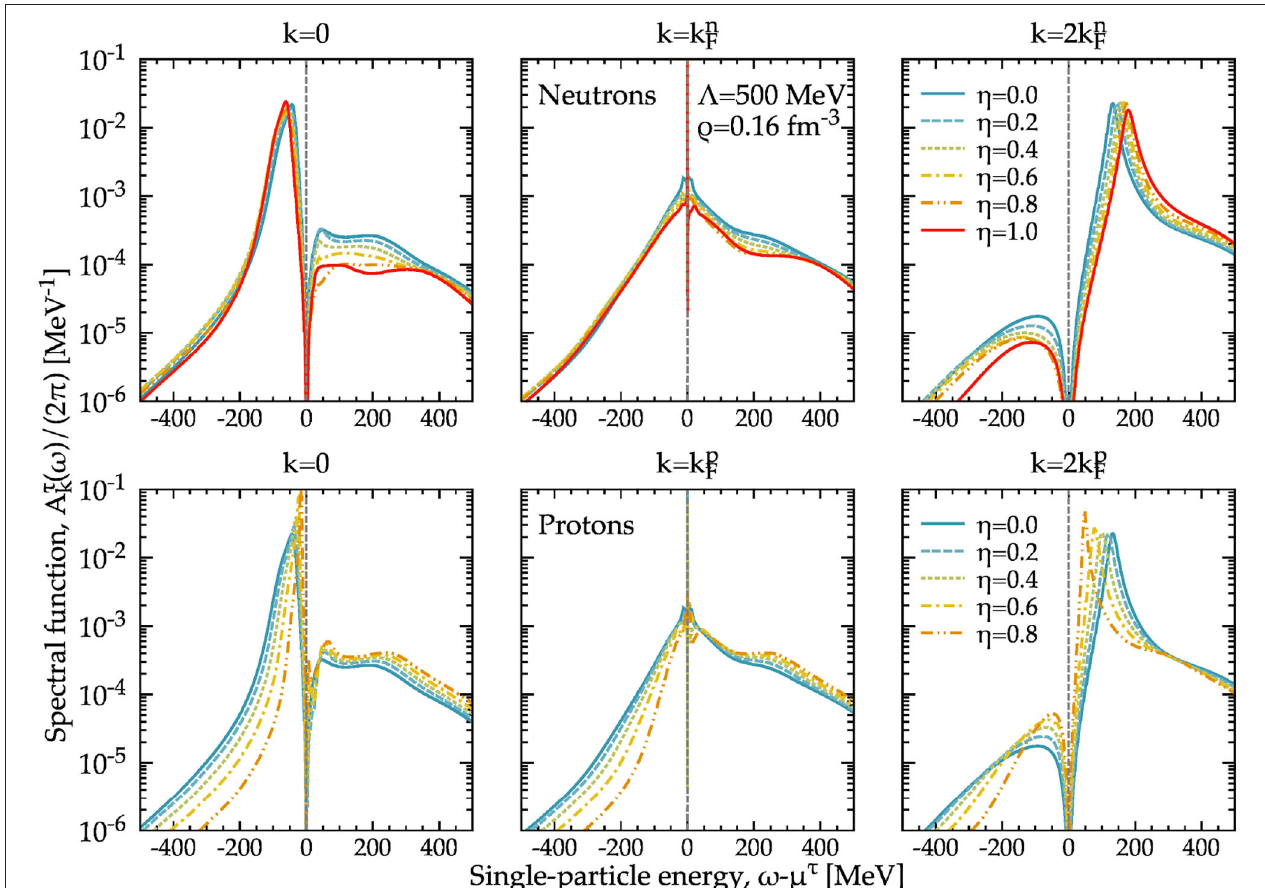
FIGURE 4 | Neutron (top) and proton (bottom) spectral functions A τ k ( ω ) as a function of energy for three different momenta: k = 0 (left) k = k τ F (central) and k = 2 k τ F (right panels). Calculations with the N3LO 3 = 500 MeV and an N2LO 3NF at a density ρ = 0.16 fm − 3 have been extrapolated to zero temperature for different isospin asymmetries η . The vertical dashed line is a guide to separate hole ( ω < µ τ ) and particle ( ω > µ τ ) components.